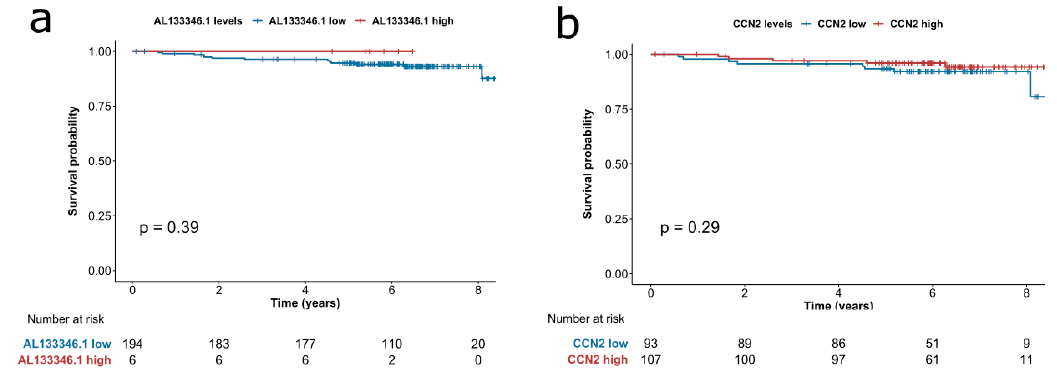
Figure A5. Kaplan ‐ Meier overall survival curves of pediatric B ‐ ALL patients divided in two groups according to whether AL133346.1 expression was above or beyond the median: “AL133346.1 high” and “AL133346.1 low”. The p ‐ value of Cox univariate analyses are shown.